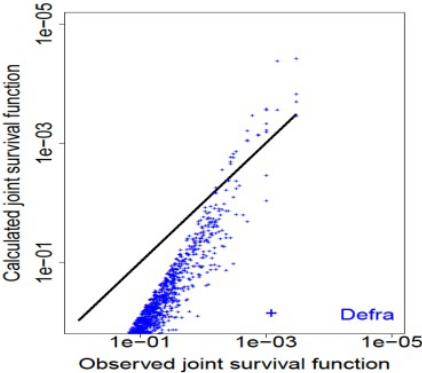
Figure 3. Comparison of calculated (with Defra method) and ob- served joint frequency for Le